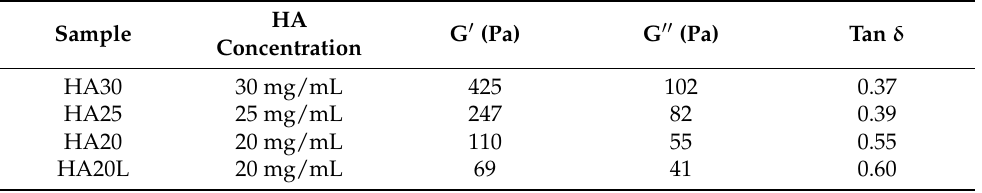
Table 1. HA concentration, elastic modulus (G ′ ) and viscous modulus (G ″ ) of four HA ‐ Lys hydrogels. Sample HA20L was prepared with a smaller amount of crosslinking agents compared to HA20.